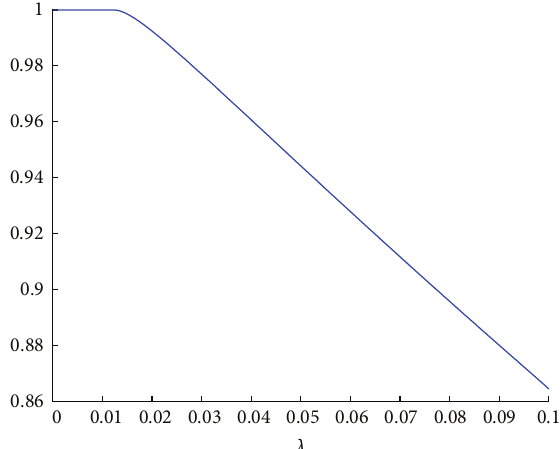
Figure 2: Loan value as a function of the intensity. The loan value is decreasing when there is a degradation of the credit quality (i.e., 𝜆 increases) and converges to 0 .